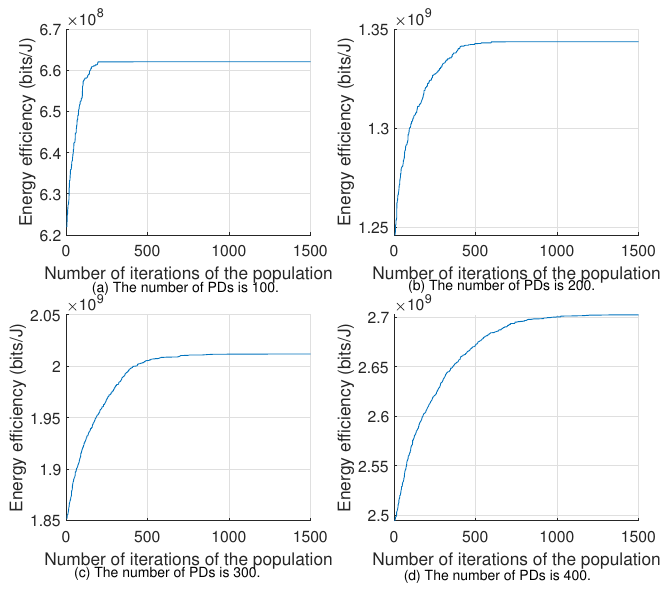
Figure 5. Convergence of Algorithm 1.